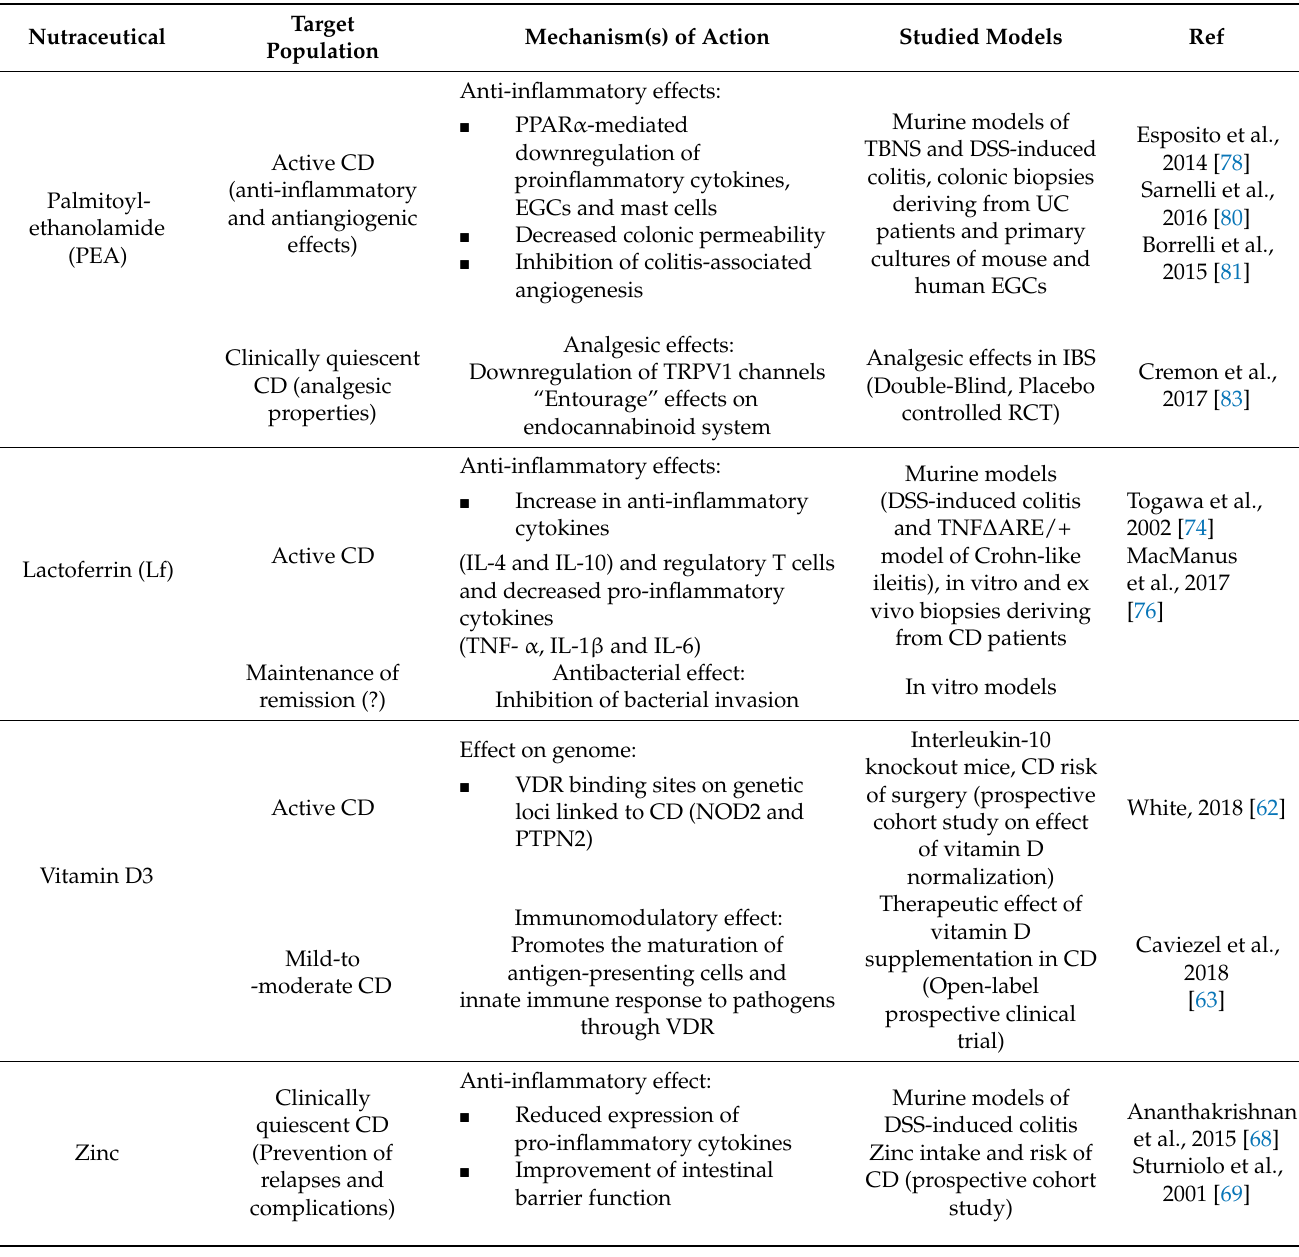
Table 3. Other nutraceuticals tested in CD, their proposed mechanisms of action and preclinical evi- dences supporting their efficacy in populations of CD patients. ECG (Enteric Glial Cells); S100B (S100 Calcium—binding protein B); TRPV1 (Transient Receptor Potential Vanilloid 1); PPAR α (Peroxisome Proliferator—Activated Receptor Alpha); VEGF (Vascular Endothelial Growth Factor); DSS (Dextran Sodium Sulphate); UC (Ulcerative Colitis); DNBS (Dinitrobenzenesulfonic acid); RCT (Randomized Controlled Trial); PGE2 (Prostaglandin E2); VDR (Vitamin D Receptor). Note: phytochemicals are not included because they are summarized in Table